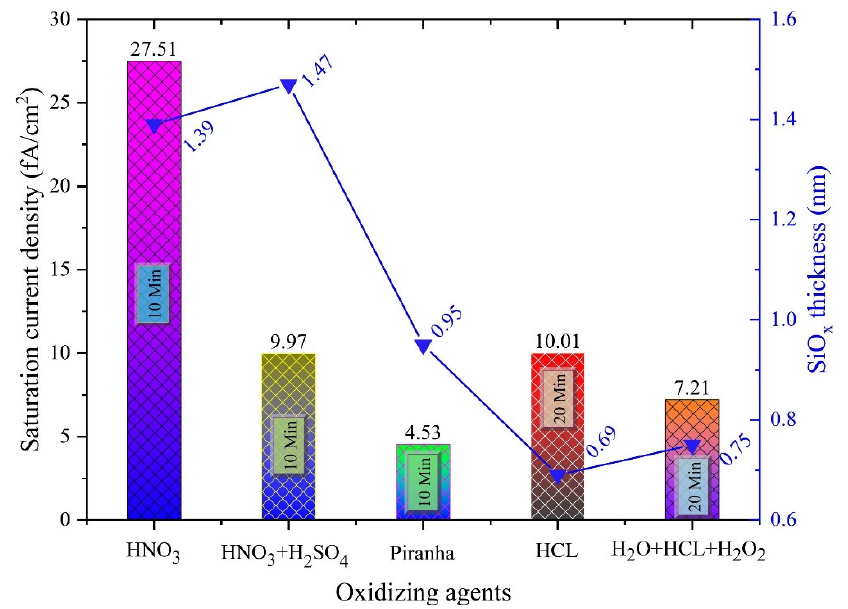
Figure 8. Development of SiO x layer thickness and consequent saturation current density J 0 employ- ing chemical oxidation method along with numerous oxidizing agents